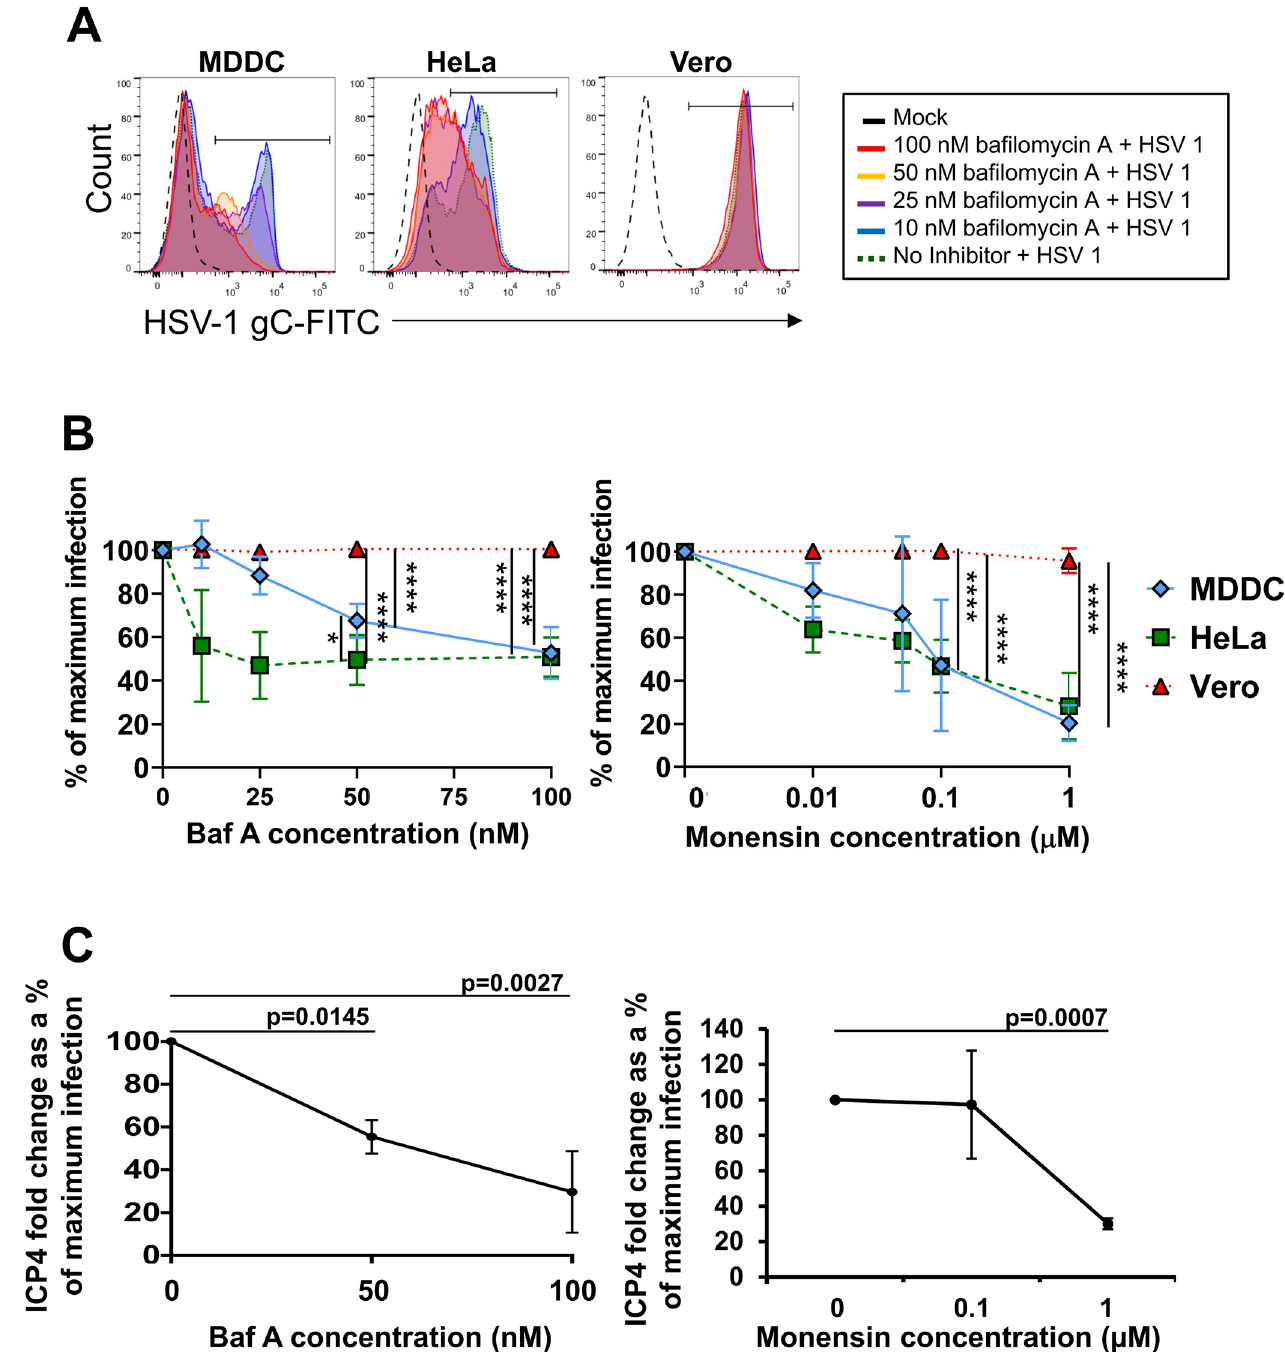
Fig 6. HSV-1 entry into MDDCs is pH-dependent and endocytic. MDDCs, HeLa and Vero cells were pre-treated with bafilomycin A (baf A) or monensin for 30 min at 37˚C at the concentrations shown. HSV-1 (strain F) was added (MOI of 3) in the continued presence of the agents and allowed to bind for 1 h at 37˚C. Cells were then washed and incubated in the presence of inhibitors at 37˚C for a total infection time of 18 h. (A and B) Cells were labelled with anti- HSV-1 gC antibody (HSV-1 gC-FITC), then analysed by flow cytometry. (A) Representative histograms of gC expression in each cell type. (B) Percentage of HSV-1 gC-FITC + cells with increasing concentrations of baf A or monensin for each of the three cell types at 18 h. HSV-1 infected cells with no inhibitor were set as 100% infection and the data are shown as the percentage of maximum infection. Two-way ANOVA with Tukey’s test for multiple pairwise comparisons was used to compare the percentage of maximum infection between cell types at each concentration of each inhibitor, n = 4 (HeLa n = 3). The ANOVA summary p values for variation in inhibitor concentration and cell type were p < 0.0001 for both inhibitors. Significant pairwise p values: 50 nM baf A : HeLa vs. Vero p < 0.0001, MDDC vs. Vero p < 0.0001, MDDC vs. HeLa p = 0.0390, 100 nM baf A : HeLa vs. Vero p < 0.0001, MDDC vs. Vero p < 0.0001, 0 . 1 μM monensin :